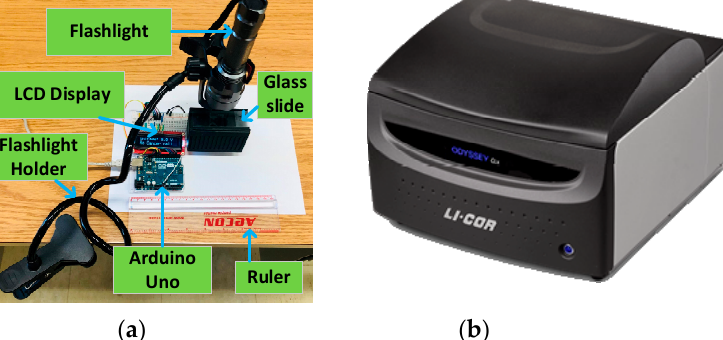
Figure 4. Experimental setup: ( a ) an overall setup of the proposed system (ruler is added in the picture to show the relative size) and ( b ) a commercial system: Li-Cor Odyssey.